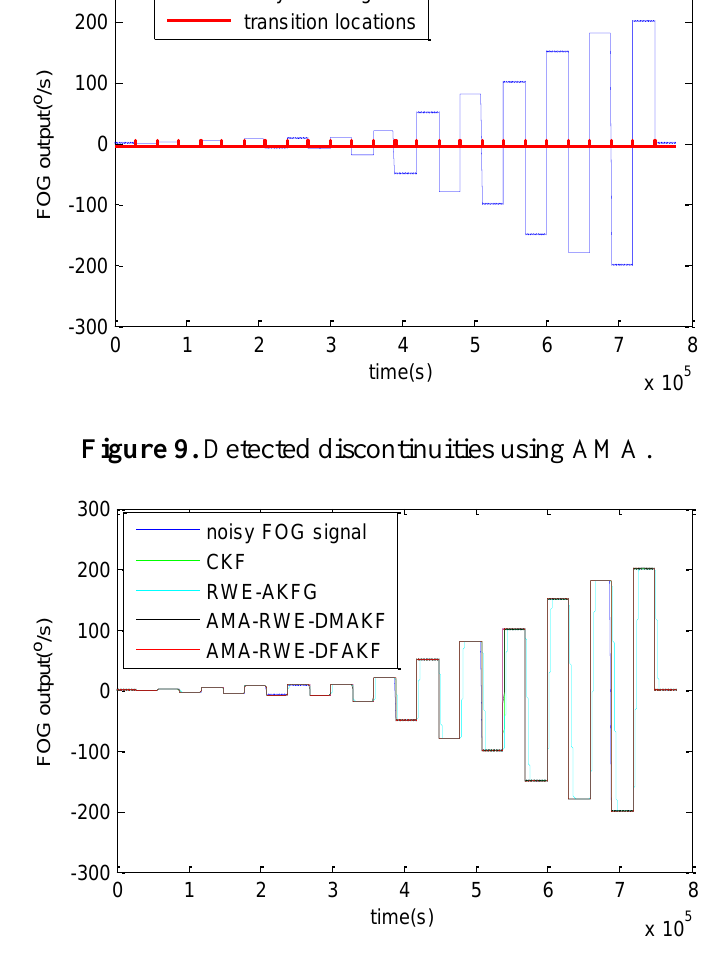
Figure 10. Denoising results of FOG dynamic signal.